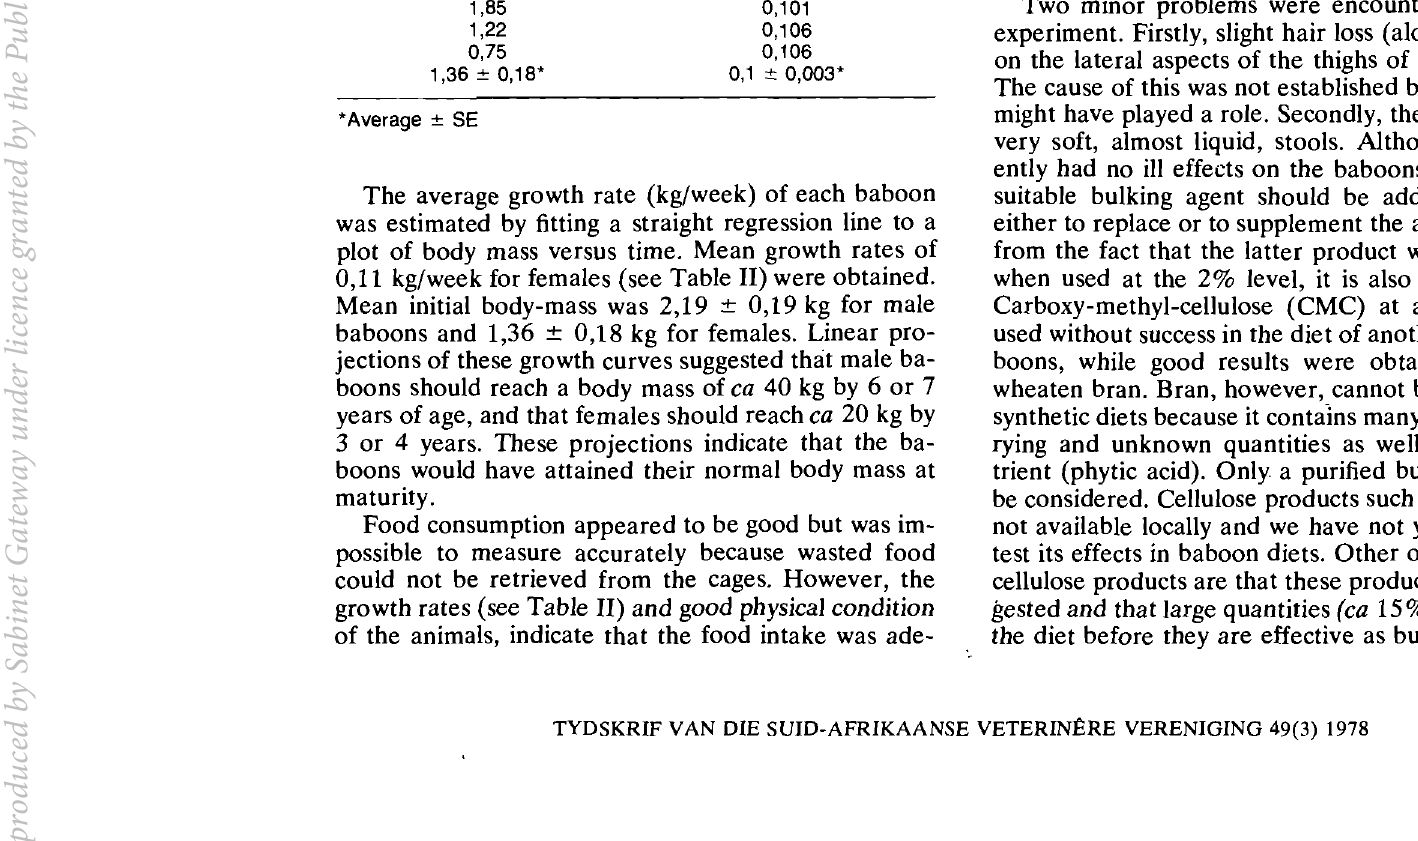
Fig. 1 Growth curves of 5 male and 5 female baboons fed on a semi-synthetic diet over 'a 70 week-period quate and that the diet tested is suitable for the feeding of young baboons in